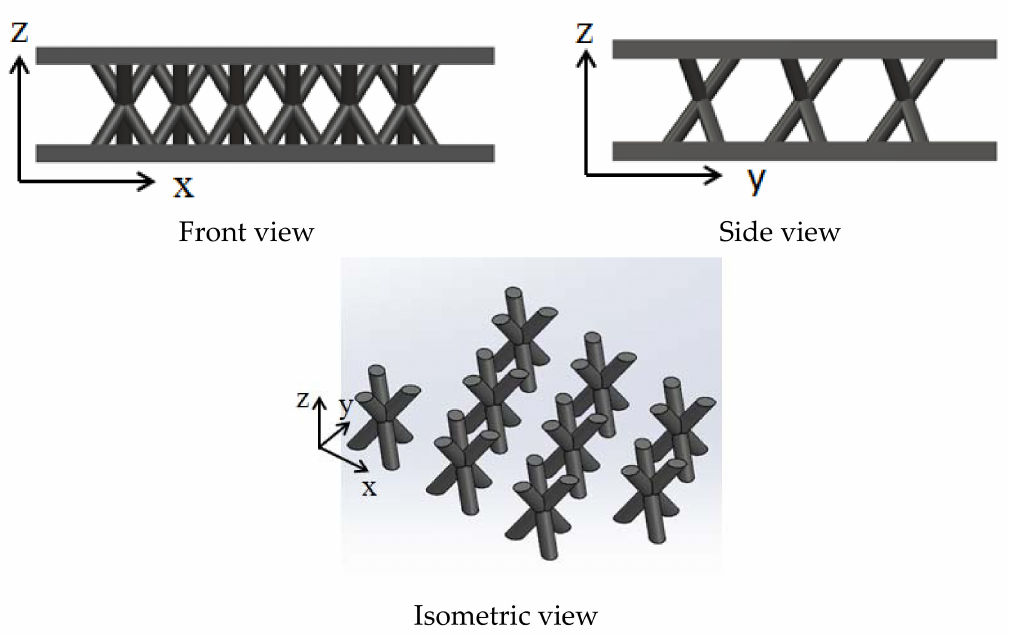
Figure 2. Front, side and isometric views of Kagome structure with 3 × 3